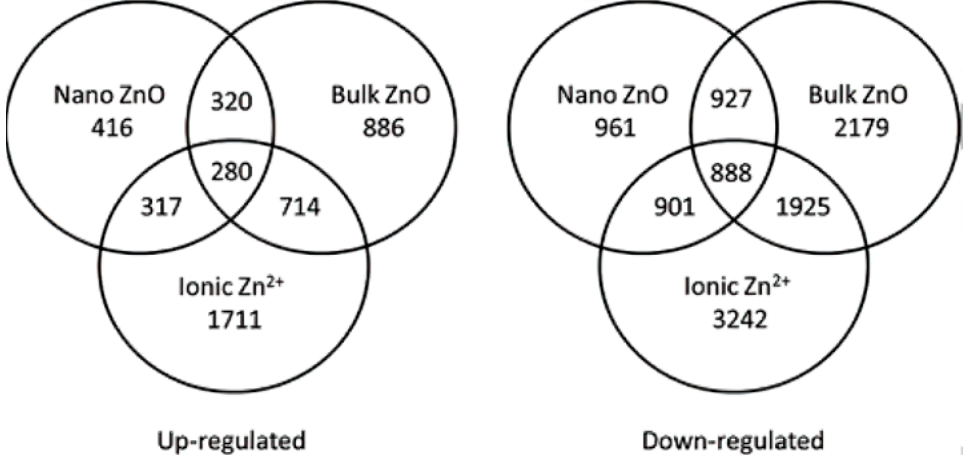
Figure 12. Numbers of up- and downregulated genes after ZnO NPs, bulk ZnO and ionic Zn 2+ exposure. Reprinted with permission from Ref. [66].